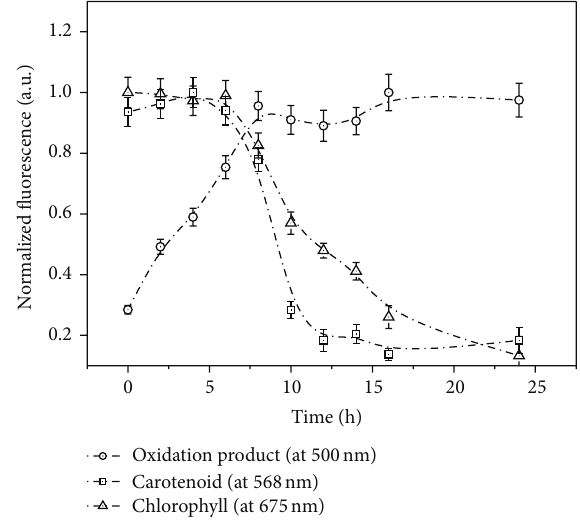
Figure 7: Fluorescence intensity at 500, 568, and 675 nm, when excited at 405 nm, as a function of the heating